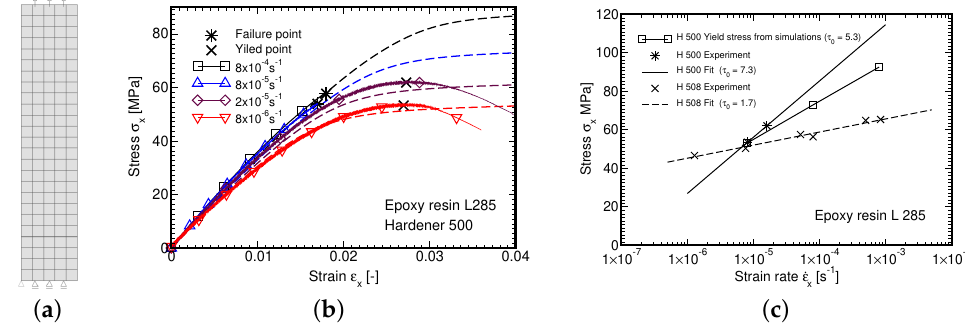
Figure 10. ( a ) Finite element mesh, ( b ) Simulation of tensile experiment, ( c ) Eyring plot.